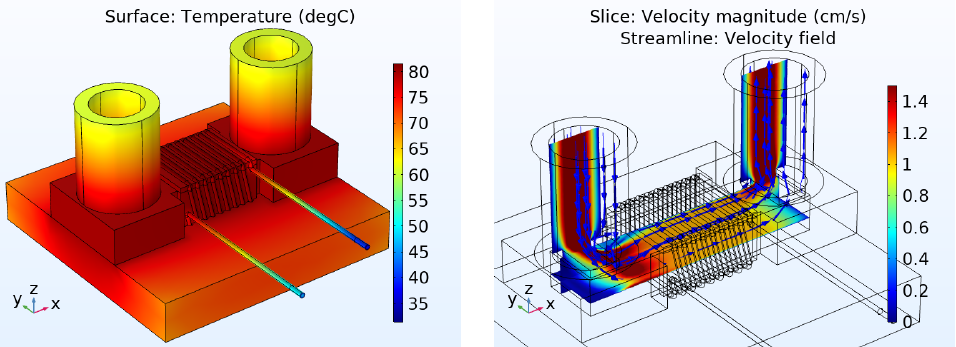
Figure 6. Simulation results: Surface temperature without cooling ( left ) and fluid velocity with active cooling ( right